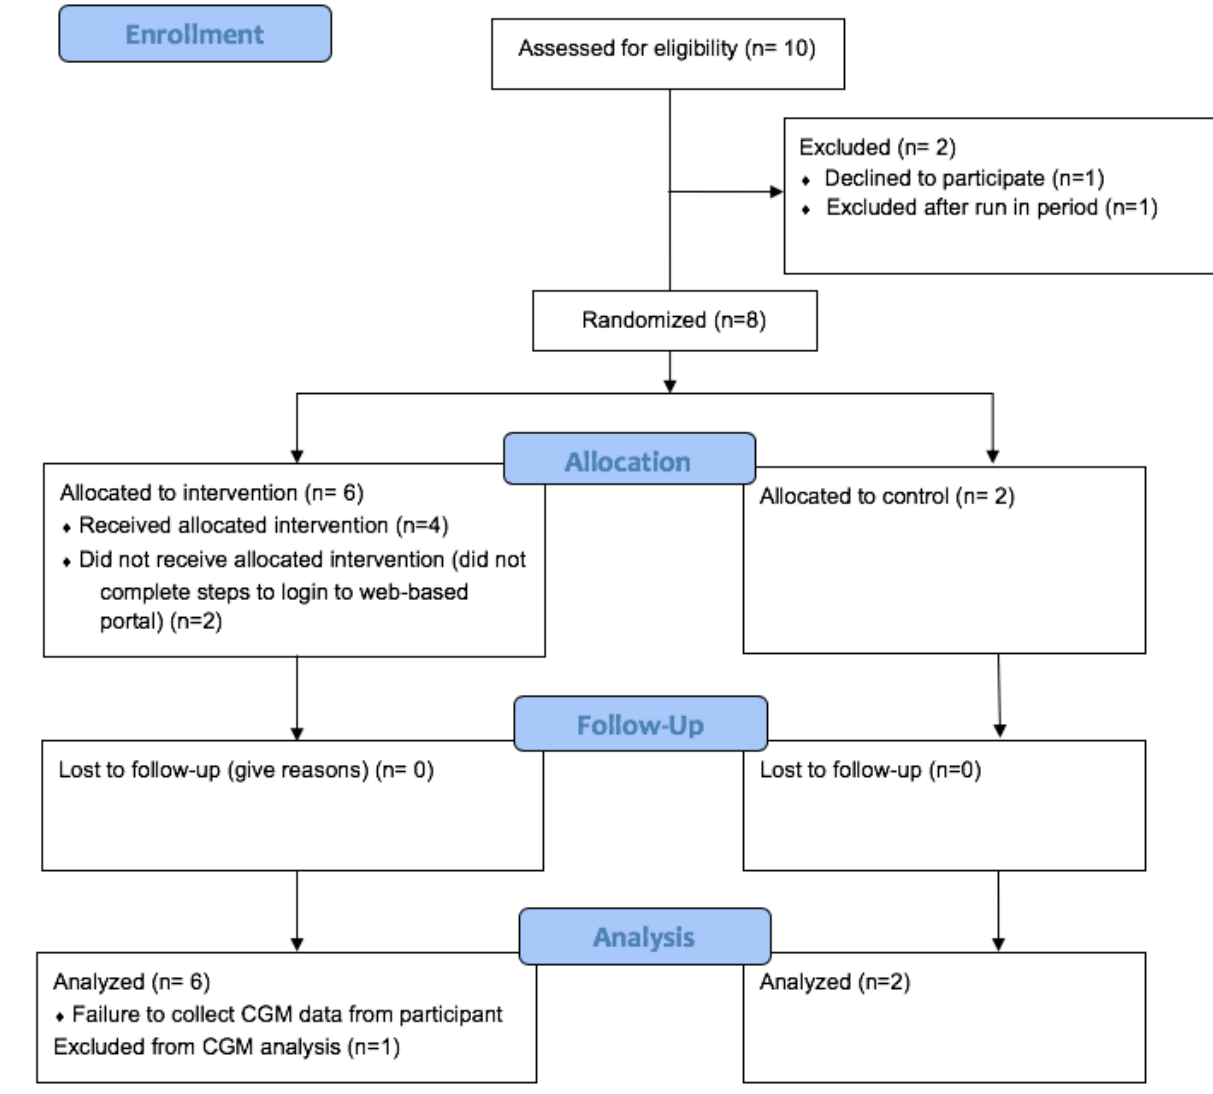
Figure 3. Study flow diagram. CGM: continuous glucose